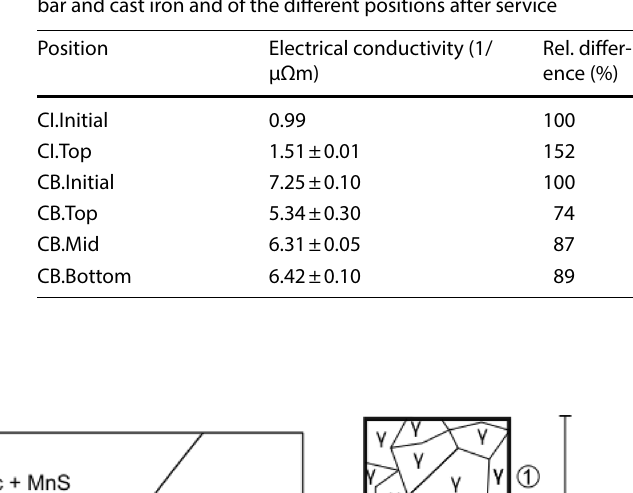
Fig. 6 Phase diagram based on the collector bar (CB.Top). The dotted line represents the iso- thermal carbon diffusion pro- cess over the time of 5.4 years. At the beginning the matrix is mostly austenitic with a low amount of ferrite (1). With increasing carbon content, the composition eventually trans- forms into a fully austenitic matrix (2), accompanied by grain growth. At the end, the carbon content has increased so much, that precipitation of secondary cementite (Fe C) 3 occurs (3)